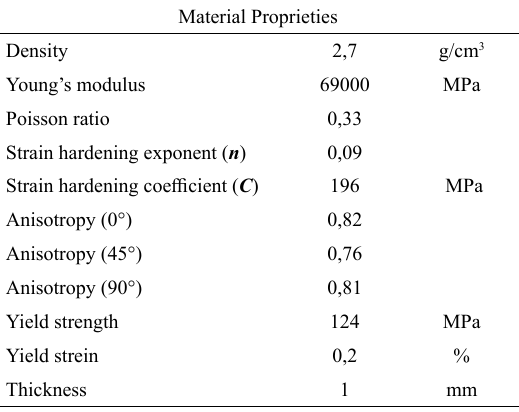
Table 1. Properties used to define the sheet material.